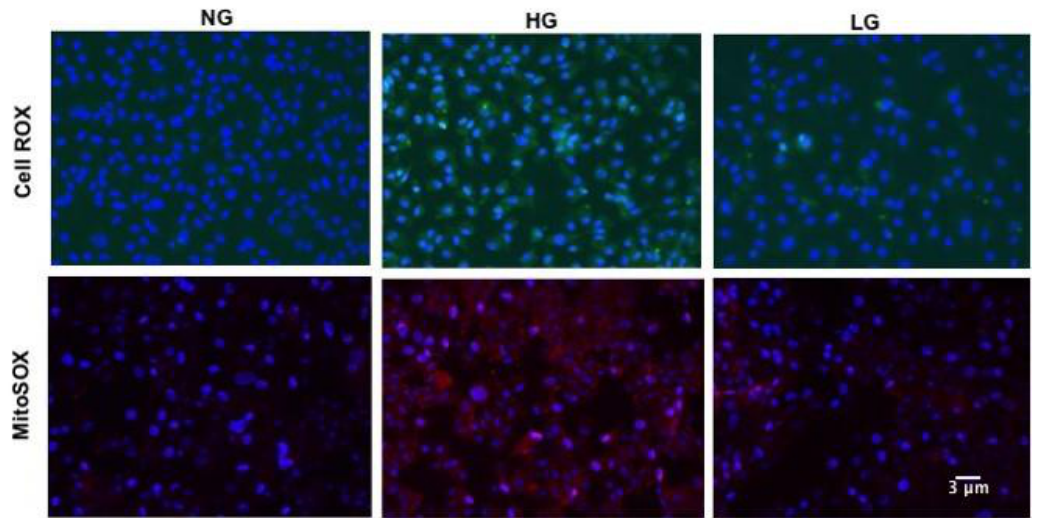
Figure 1. E ff ects of high glucose on miR-34a and endothelial cells senescence. ( A ) Bar histograms representing miR-34a levels measured by qPCR in HuREC treated for 48 h with high glucose (HG; 25 mM d -glucose, black bar) in comparison to cells treated with normal glucose (NG; 5 mM D-glucose, light grey bar) or the osmotic control l -glucose (LG; 25 mM L-glucose, dark grey bar). ( B ) Micro images showing SA- β -Gal (senescence-associated beta-galactosidase) staining (blue cells) in HuREC exposed for 72 h to di ff erent glucose concentrations (NG and HG) or the osmotic control LG. ( C ) Bar histograms representing percentage of SA- β -Gal positive cells versus total number of cells counted per field. Ten consecutive fields per sample were counted in a blinded fashion. ( D – F ) Immunoblotting analysis determining protein levels of ( D ) SIRT1, ( E ) p16INK4a, and ( F ) p21Waf1 in HuREC exposed to HG for 72 h (black bar) and compared to NG (light grey bar) and LG (dark grey bar) controls. Protein levels are expressed (bar histograms) as band density normalized versus actin. Bars represents mean value ± S.E.M; * p < 0.05 vs. NG, n = 4.